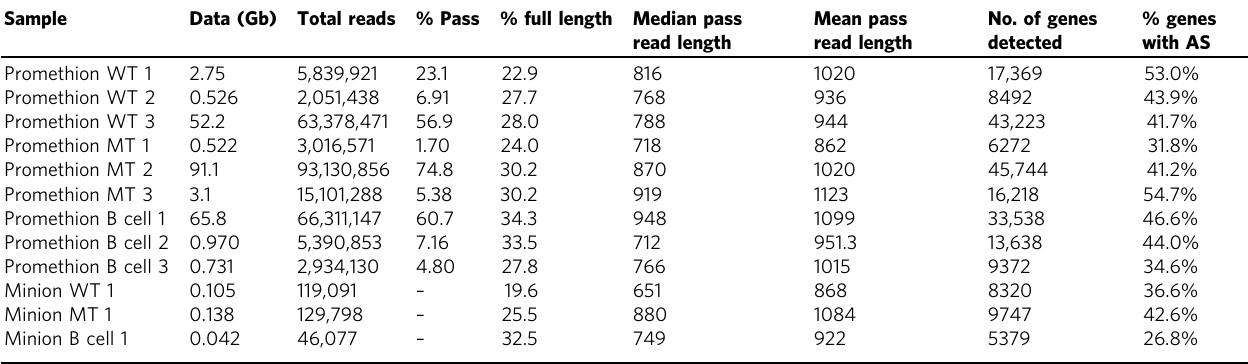
Table 1 Nanopore-sequencing statistics. Sample Mean pass